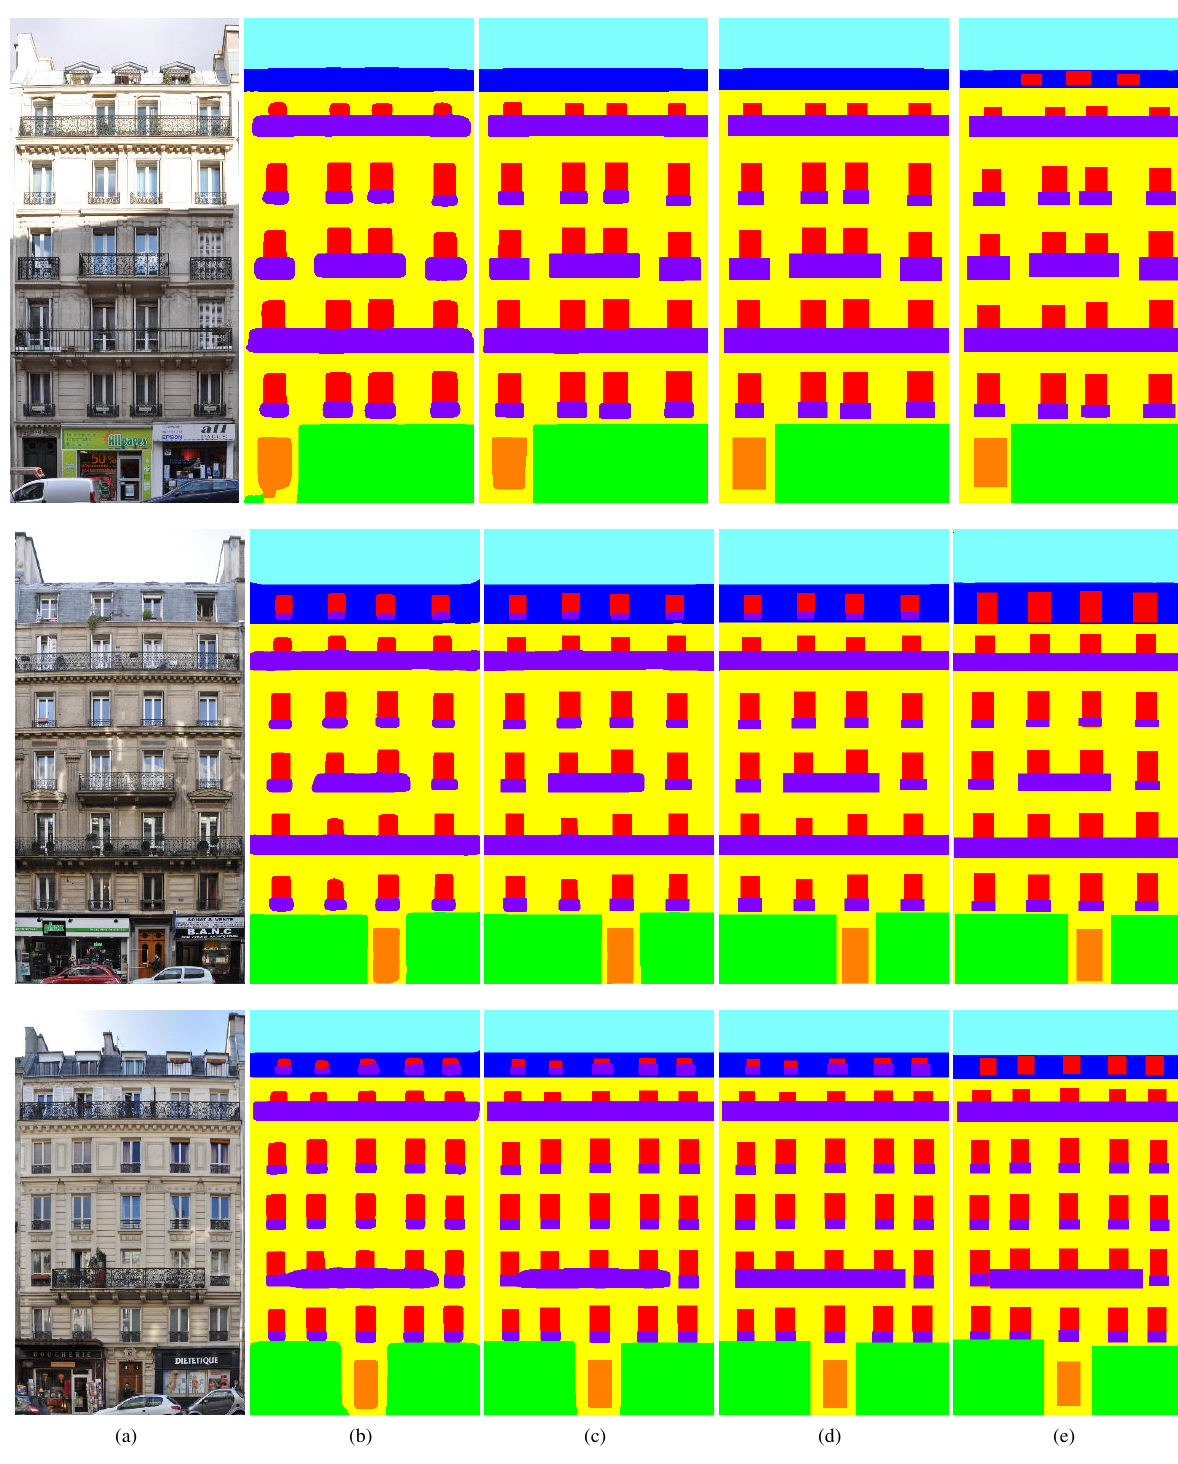
Figure 5. Qualitative results on the ECP dataset. The facade segments are homogeneous and nearly without noise. Column (a) input images, (b) results from Structured Random Forests with Regional Proposal Network, (c) results after 19 iterations of optimization, (d) results after Rectangular fitting, (e) ground truth. Object